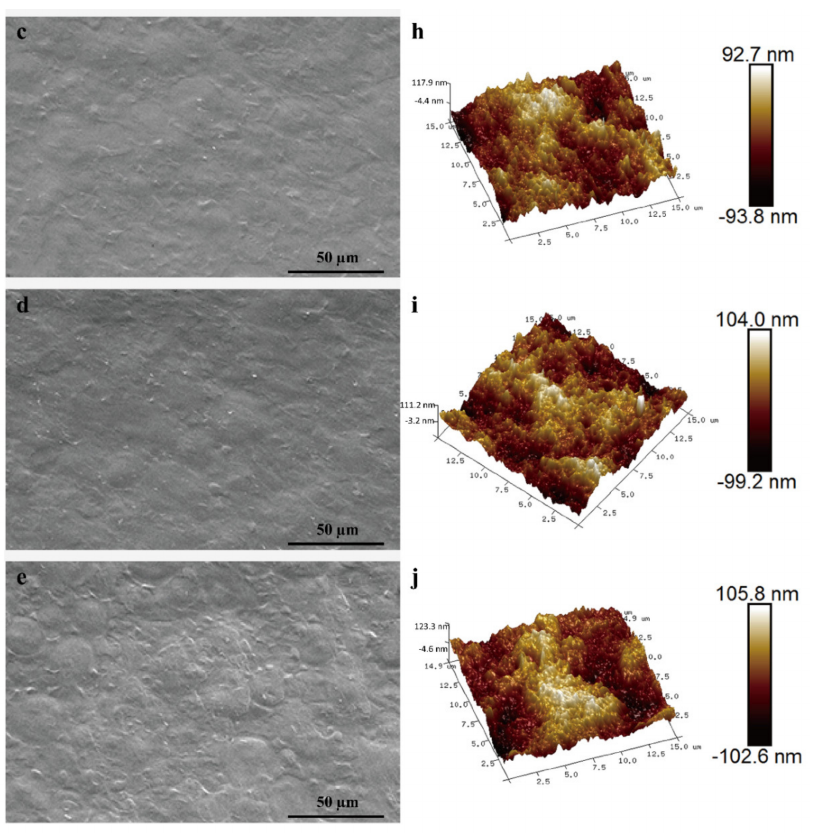
Figure 1. SEM ( a – e ) and AFM ( f – j ) images of active films with different RCAE contents: S0 ( a , f ), S1 ( b , g ), S2 ( c , h ), S3( d , i ), and S4 ( e , j ).